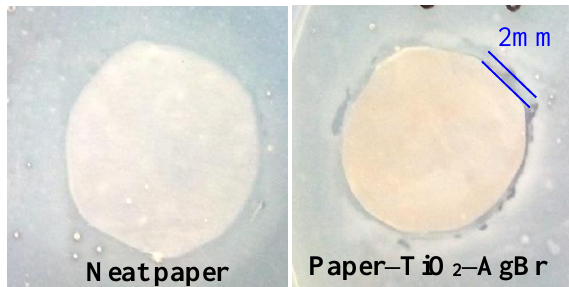
Figure 8. Digital images of the neat paper and paper–TiO 2 –AgBr samples placed in E. coli culture medium after incubation at 37 °C for 24h under daylight.